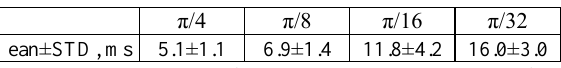
Table 6. Processing time of the brain tumour segmentation for different ∆φ (number of rays)